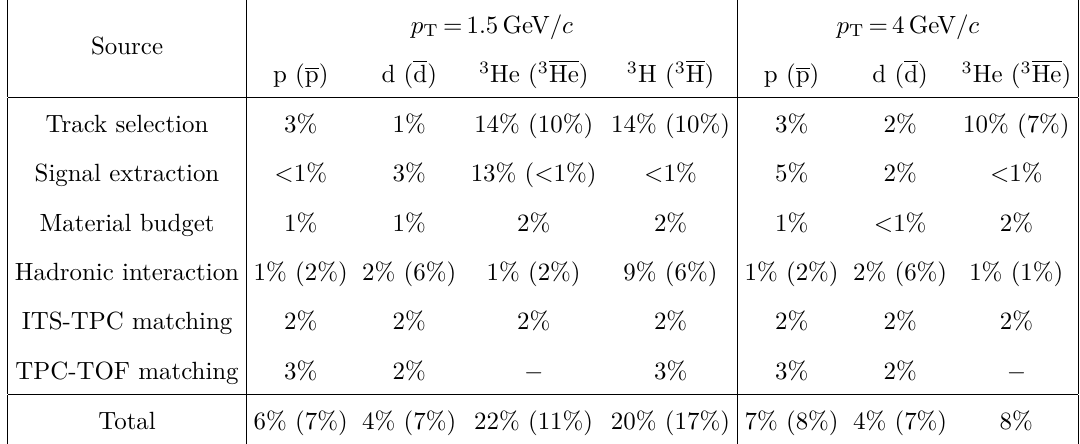
Table 1. Summary of the main contributions to the systematic uncertainties for all the particle species under study at p T = 1 . 5 GeV/ c and at p T = 4 GeV/ c . Values in brackets refer to antiparti- cles. If they are not present, the systematic uncertainty is the same for particles and antiparticles. A dash symbol is used where the uncertainty from the corresponding source is not applicable. More details about the sources of the uncertainties can be found in the